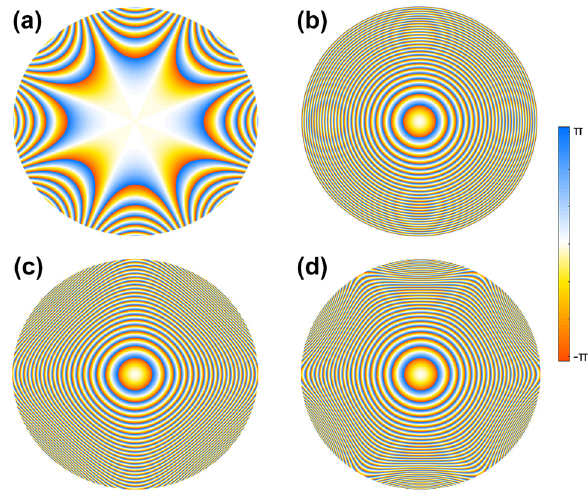
Figure 2: Phase design for generating PBs. (a) The phase profile used to generate the PB with m = 4 in the K space.(b)Thephasepro fi leoftheFresnellens.(c)and(d)Thephase pro fi les to generate the PBs with m = 4 and m = 6 in the real space, respectively.